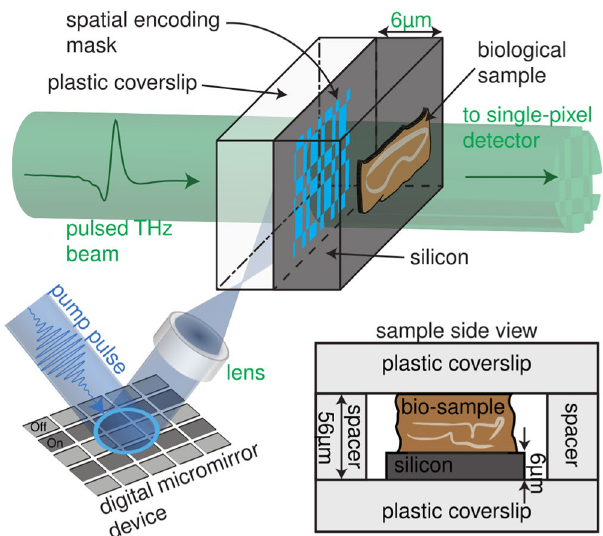
Figure 1. The experimental scheme: an optical pump pulse is spatially modulated and used to photoexcite a thin silicon wafer, which, in turn, transfers the spatial encoding mask onto a coincident THz pulse. The subsequent THz pulse is then passed through a biological sample onto a time-gated, single-element detector. By varying the arrival time of the electro-optic sampling pulse, we measure the full temporal trace of our THz